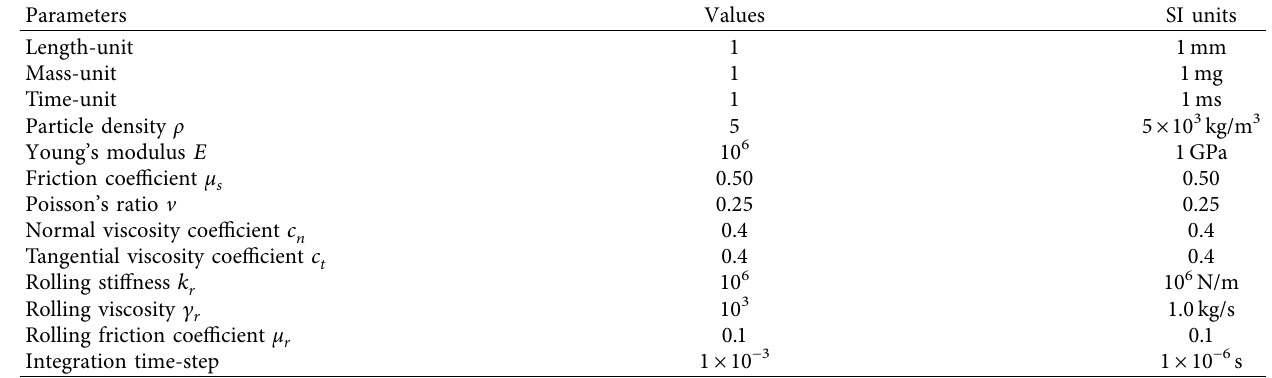
Table 5: Parameters of simulations.